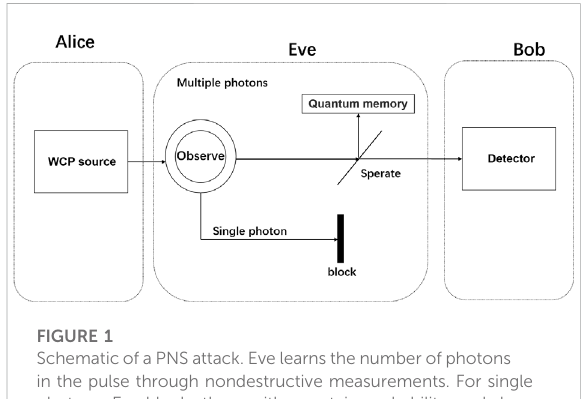
FIGURE 1 Schematicof a PNS attack. Eve learns the number of photons in the pulse through nondestructive measurements. For single photons, Eve blocks them with a certain probability, and she separates one photon from multiphotons.